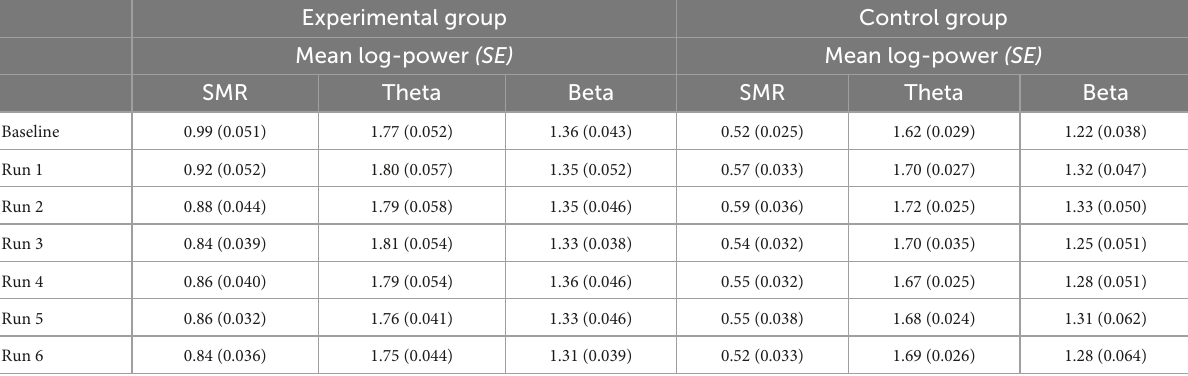
TABLE 3 Within session changes (averaged across seven runs per session) in mean log-transformed SMR, Theta and Beta power, presented separately for the experimental and control group with Cosineau-Morey transformed standard errors.